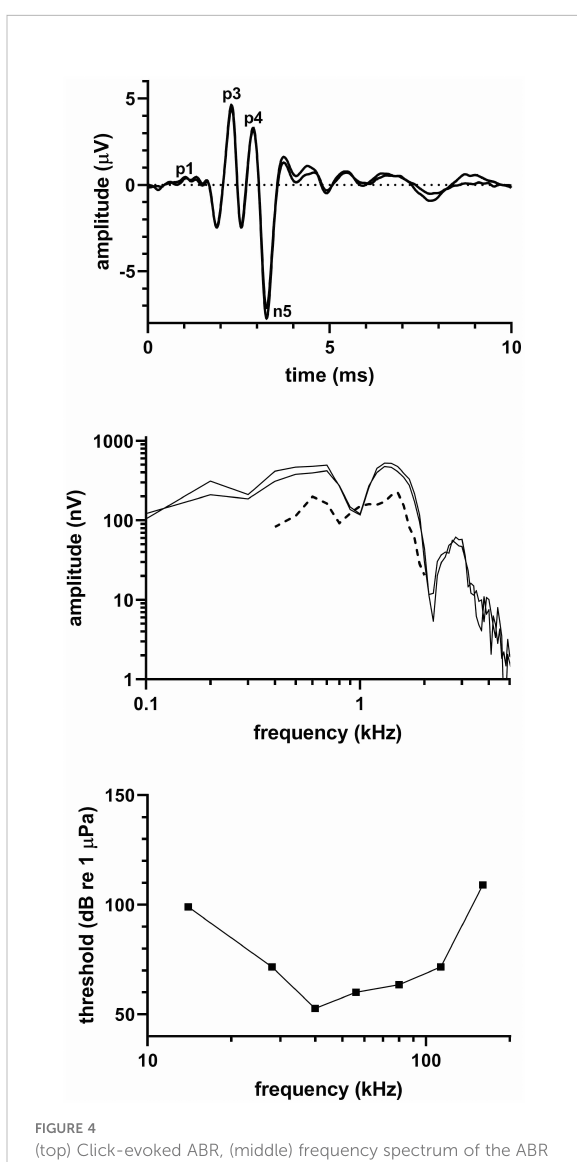
FIGURE 4 (top) Click-evoked ABR, (middle) frequency spectrum of the ABR waveform [solid line] and MRTF [dashed line], (bottom) and audiogram for the northern right whale